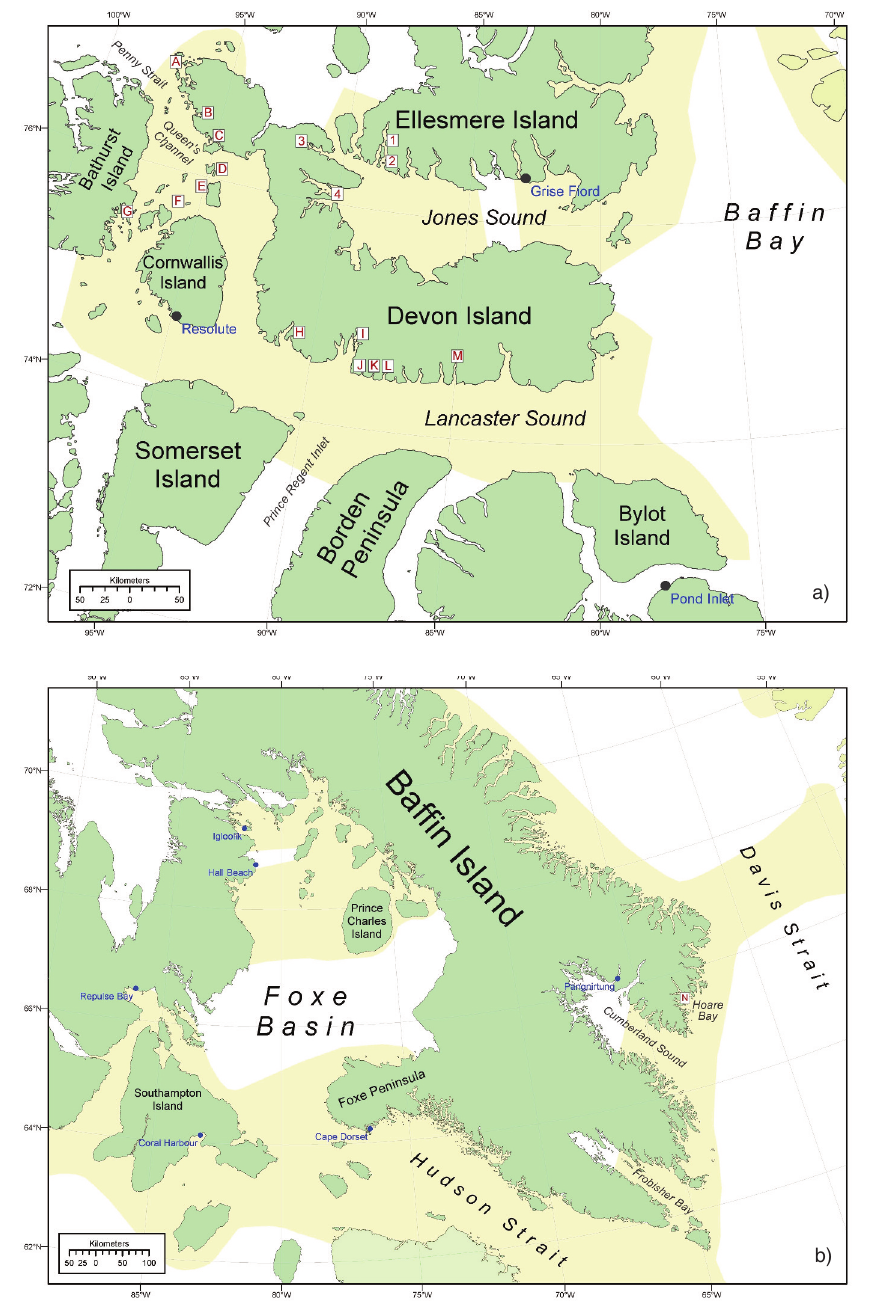
Fig. 2. Sampling locations and place name used in the text (a) high Arctic locations and (b) central Arctic locations. Site designations are also presented in Appendix I. 1. Mount